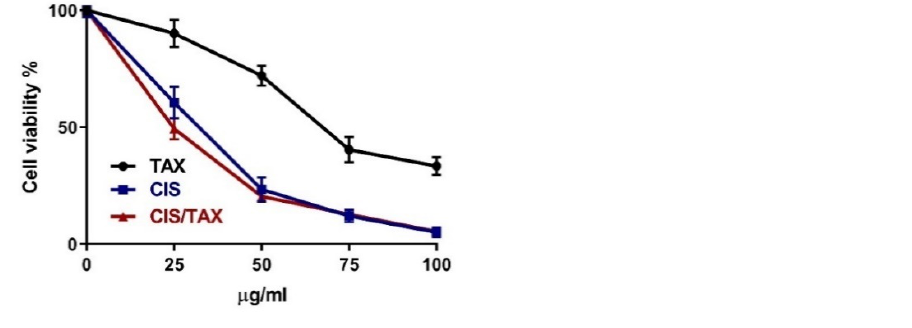
Figure 8. TAX does not interfere with the anti-proliferative activity of CIS. Data are mean ± SEM. The experiment was repeated three times ( n = 3).